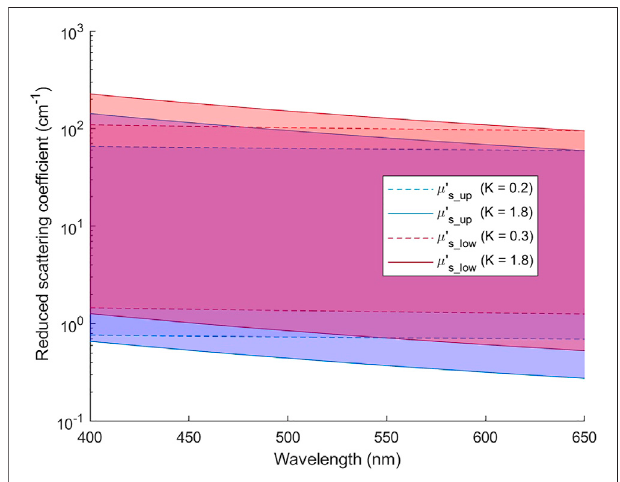
FIGURE 3 | Ranges of μ s ′ ( λ ) for the upper and lower layers that are covered in the iterative curve fi tting of re fl ectance